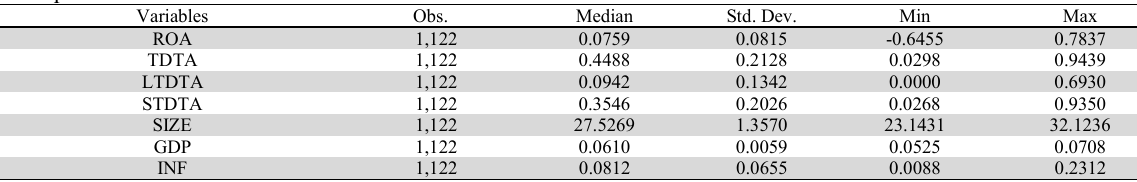
Descriptive statistics of variables